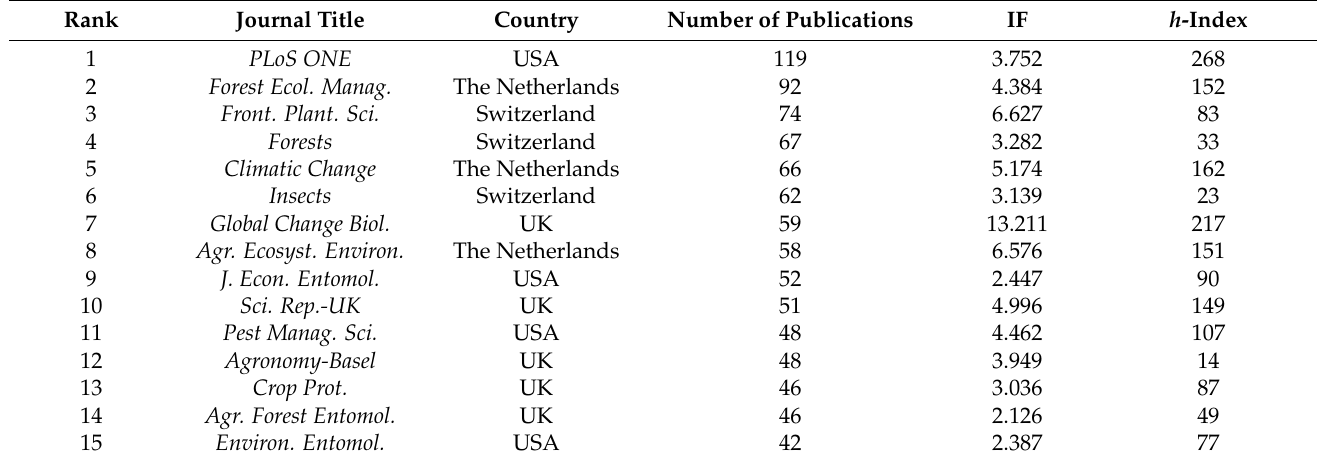
Table 1. Top 15 Journals in terms of number of articles